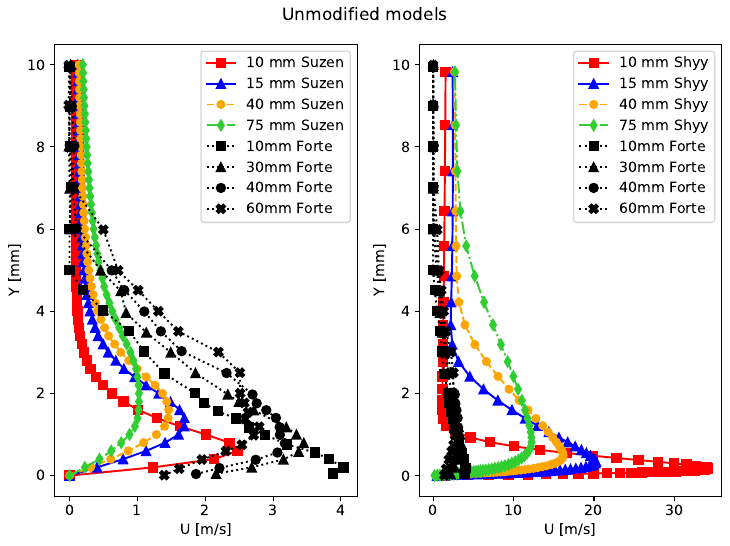
Figure 14. Velocity profiles for the unmodified models (case 3 setup) at 20 kV and 1 kHz.